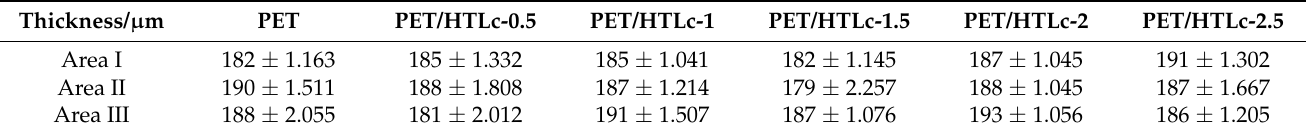
Table 1. Thickness of composite